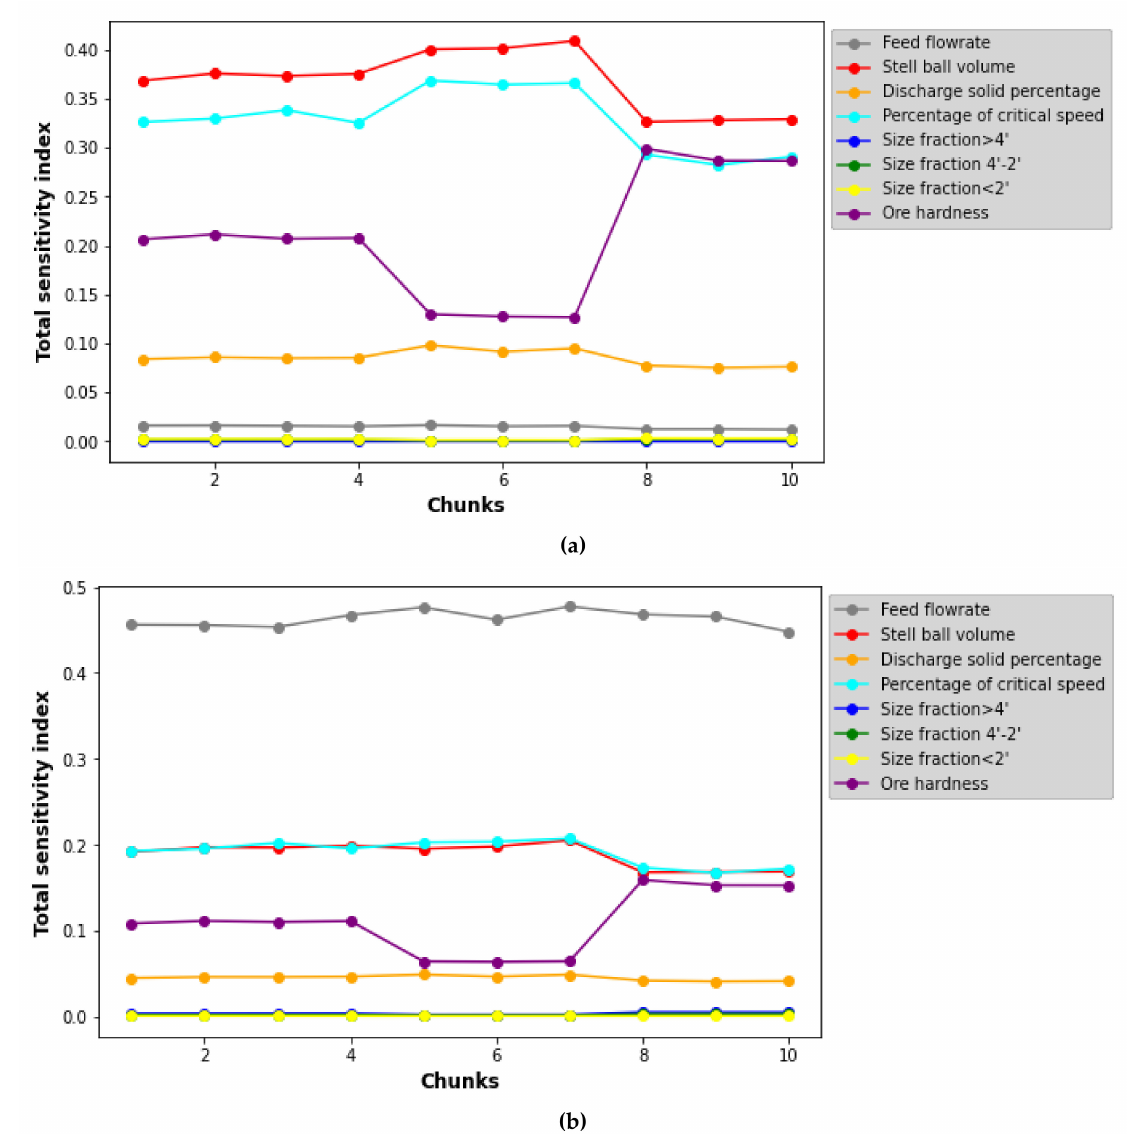
Figure 10. Sobol indices with different magnitudes of uncertainty for SMs built via online sequential training. ( a ) Power consumption, ( b ) Specific comminution